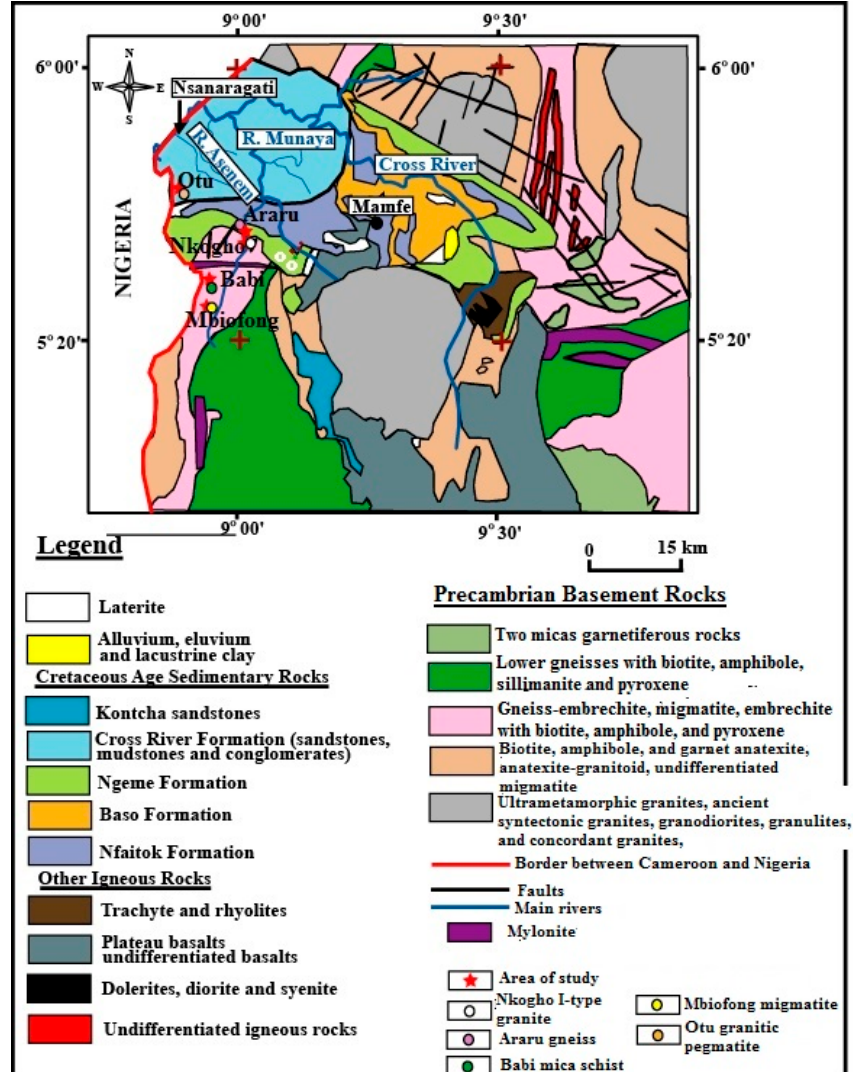
Figure 2. Sketched geologic map of the Mamfe Basin locating the study area and rocks from [38]. Basement rocks around the Mamfe Basin consist of gneisses, migmatites, granites, syenites, and mica schists (Figure 2) that recorded ductile and brittle cataclastic tectono- magmatic/metamorphic events [5,6,36–38,106]. The dominant strike direction for foliated rocks is E-W with occasional swings to the N and S [36,37,106]. Most gneisses belong to the Central African Mobile Zone or Cameroon Mobile Belt [37]. A recent study of the Otu granitic pegmatite (very coarse-grained to inequigranular) and Babi mica schist (slaty to weakly foliated and lepido-grano-porphyroblastic) show that they are, respectively, composed of: (1) microcline, orthoclase, mono to polycrystalline quartz, biotite, and clinopyroxene and (2) muscovite, biotite, and mono to polycrystalline quartz [5,38]. The obtained U-Pb zircon ages (ca. 490–653 Ma, close to those of most intrusive rocks within the Cameroon Mobile Belt) for the Otu granitic pegmatite dated to an Early Precambrian to Cambrian emplacement with progressive cooling of the source magma [5]. For [5], the Babi mica schist, with the variable U-Pb zircon ages (ca. 529–2019 Ma), was probably formed (during Calymmian period) from the metamorphic transformation of Paleoproterozoic clastic sediments sourced from magmatic rocks that were later affected by the PanAfrican tectono-metamorphic events. U-Pb zircon geochronology of arc-like and I-type granitoid outcropping in Nkogho in the south of this basin yielded an age range of 988 to 108 Ma, showing that this rock was formed during the Cryogenian to Ediacaran times and was